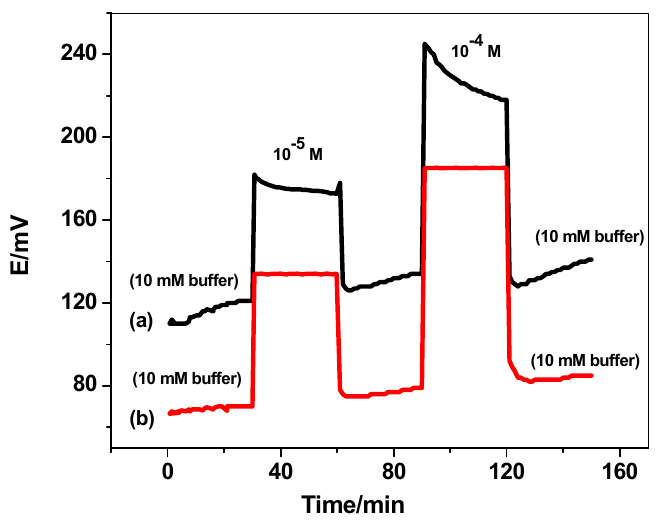
Figure 5. Long-term potential stability test for ( a ) C/MIP-ODV and ( b ) C/SWCNTs/MIP-ODV.